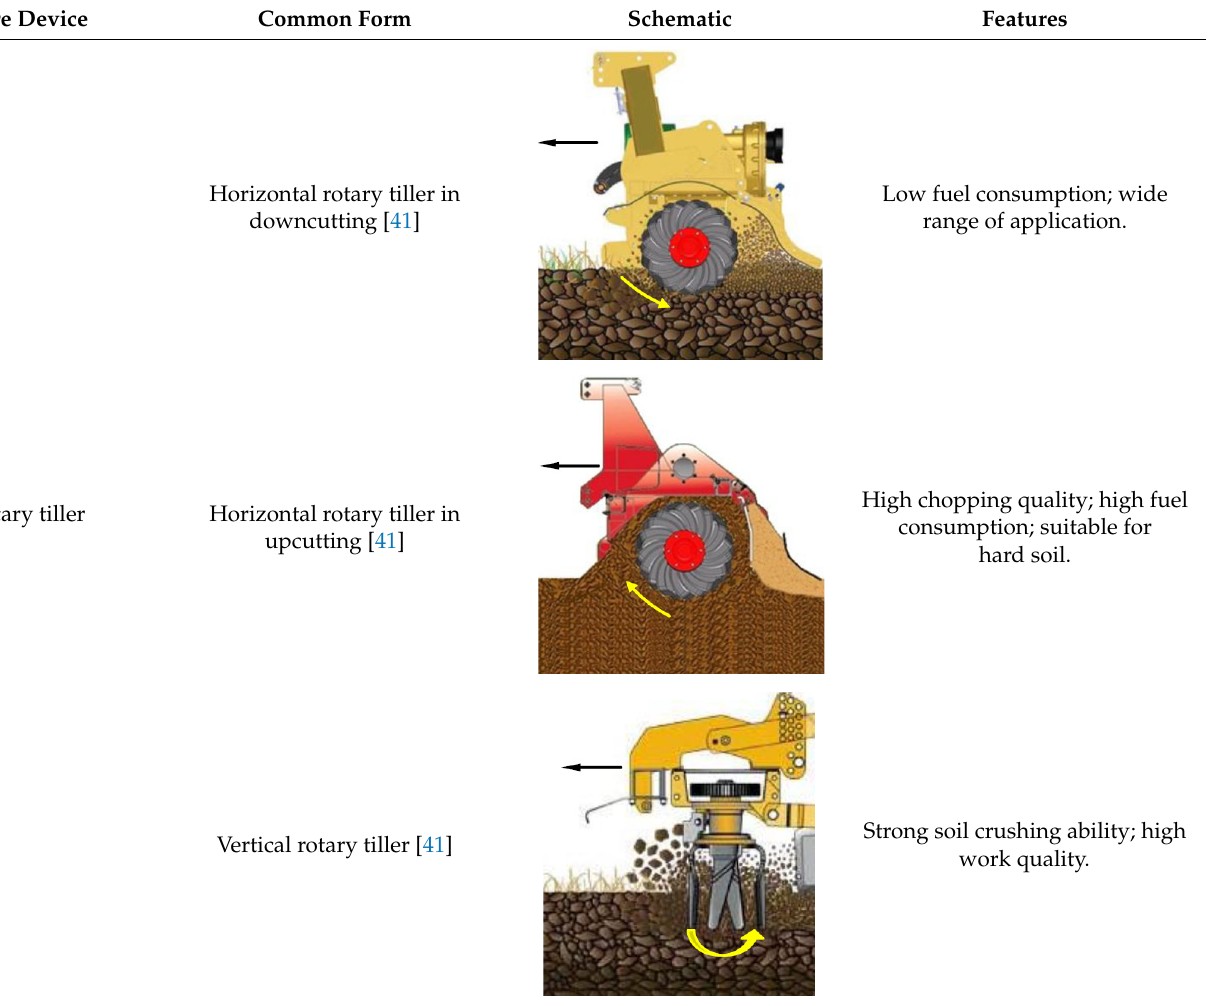
Table 6. Common types of rotary